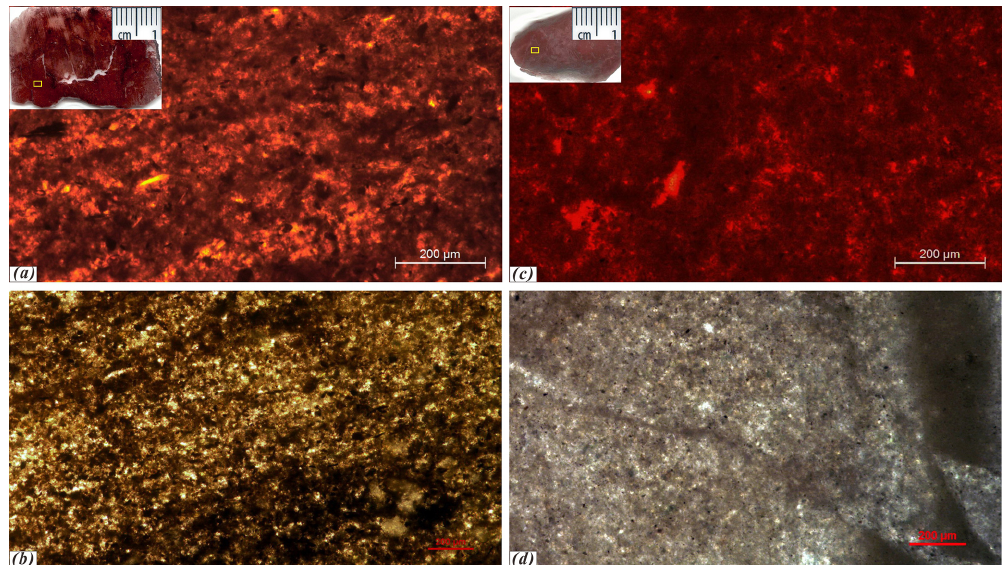
Figure 2. Microscopic cathodoluminescence and polarized light photos of representative calcrete samples from the Ziliujing Fm at the Shaping section, Ya’an: (a) and (b) Sample J1z-12-01, Bed B12, Ma’anshan Member; (c) and (d) Sample J1z-22-01, Bed B22, Da’anzhai Member. Pedogenic calcites are mainly null to non-luminescent, minor are orange and red luminescence. Inserts are the scanned photos of thin section, and rectangles are the area under cathodoluminescence and